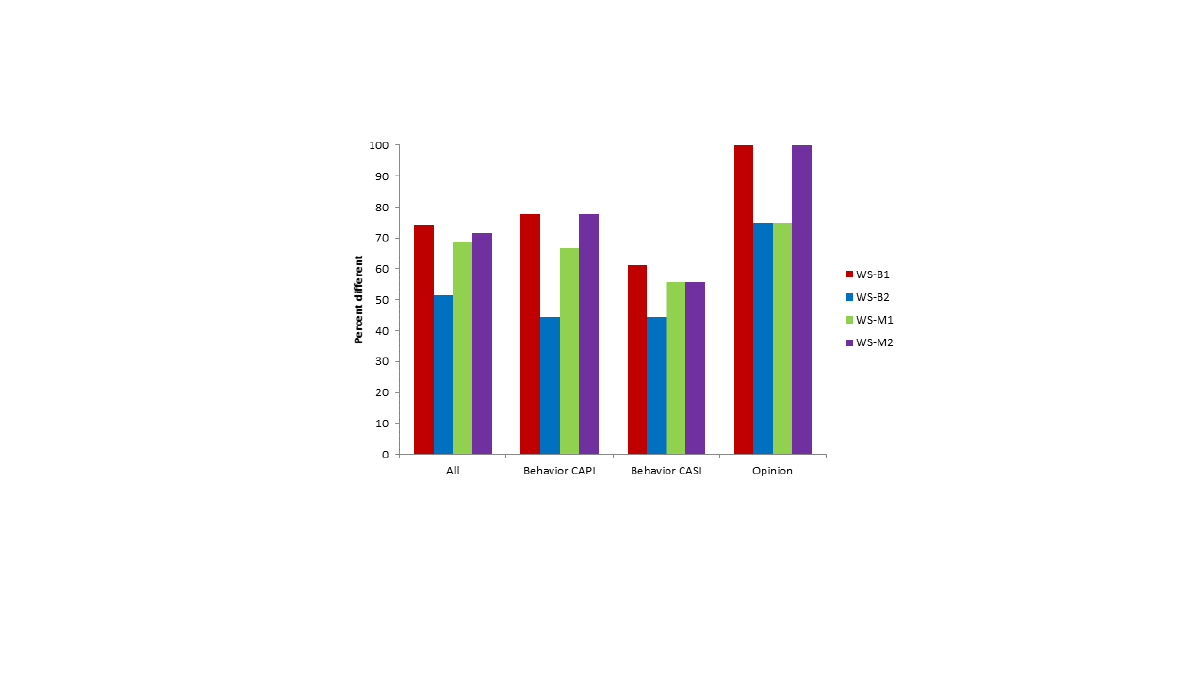
Figure 5. Women: Percentage of variables (all: n=35; behavior CAPI: n=9; behavior CASI: n=18; opinion: n=8) in 4 Web surveys significantly different from Natsal-3.